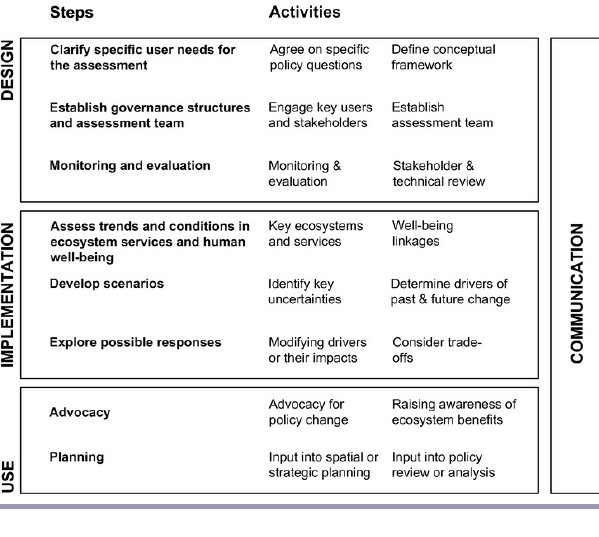
Fig. 2 . Analytical framework for exploring